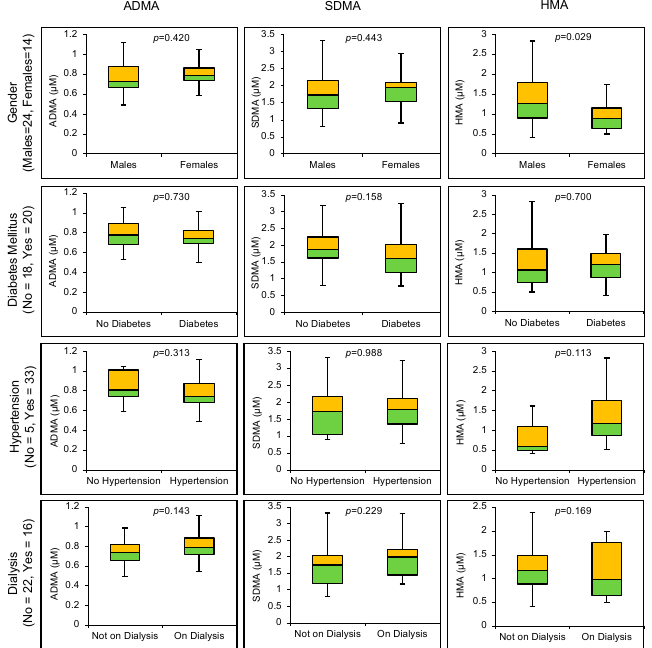
Figure 2. Association between arginine metabolites and patient baseline characteristics: gender, diabetes mellitus, hypertension and dialysis. SDMA concentrations were inversely associated with BMI (r = − 0.432, p = 0.007). Worsening renal function (as denoted by reducing eGFR) was associated with higher SDMA concentrations (r = − 0.472, p = 0.003). Troponin T concentrations were positively correlated with ADMA concentrations (r = 0.444, p = 0.006) and negatively correlated with